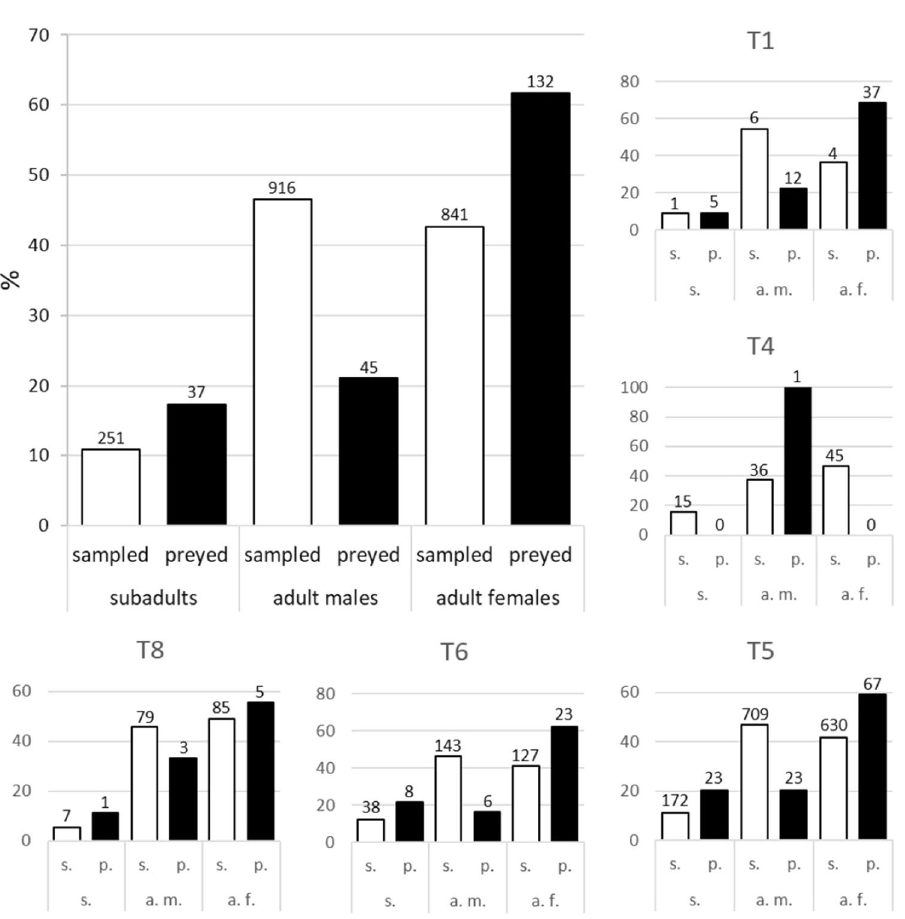
Figure 4. Comparison of the stage and sex structure of the tortoises sampled and predated by golden eagles in the study area. Data are shown for all eagle territories where both sampled and preyed tortoises were available, either pooled (large panel) or separately (small panels). Data for all study years were pooled (see text for more details). The number of tortoises of each class is shown above the